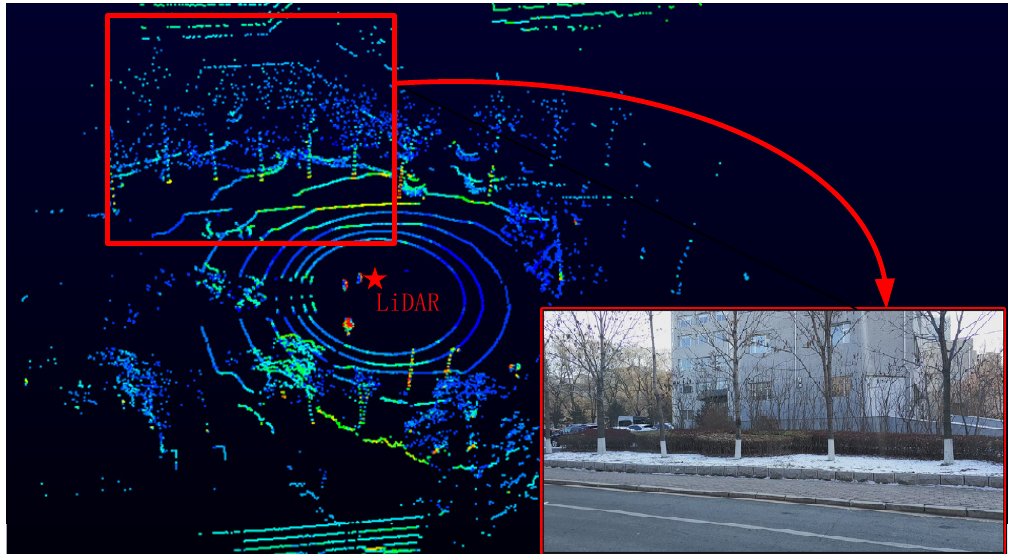
Figure 1. A frame of a light detection and range (LiDAR) point cloud displayed by the VeloView and the corresponding field photo.